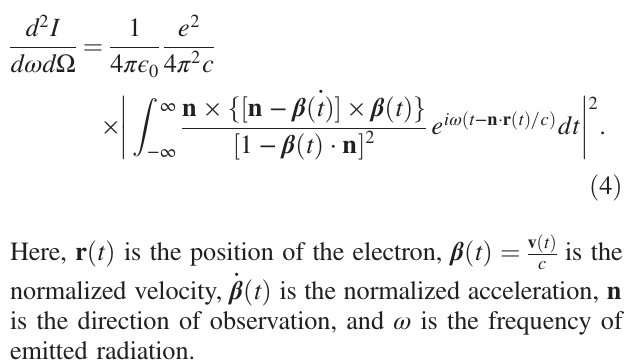
TABLE I. Summary of the x-ray source parameters for the SM-LWFA (plasma lengths 4 cm) and the blowout regimes (plasma length 9 cm). Q is the maximal electron charge above 70 MeV contained in the wakefield during max the simulation. N γ is the number of photons emitted on the interval 2 – 60 keV and in an angle 100 × 100 mrad 2 . Θ is the FWHM angle of emission (mrad) and E γ the total energy of these photons. L FWHM its rms duration. B is the brilliance at 10 keV ð photons = s = mm 2 = mrad 2 = 0 . 1% BW Þ . size of the source and D rms n (cm − 3 e